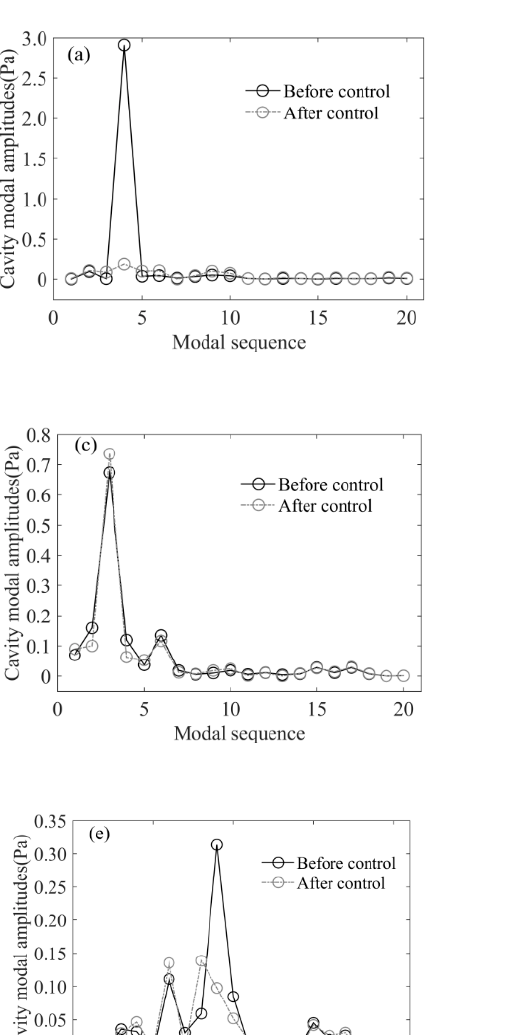
in Figure 7 (Case 3) and Table 6 (Case 3). Note that the (0,1,0), (1,1,0), (2,1,0) and (3,1,0) cavity modes can also transmit energy to the (2,2), (3,2) and (1,2) base plate modes with a substantial quantity. However, the energy contributions from the (0,1,0), (1,1,0) modes are just out of phase with those of the (2,1,0) and (3,1,0) modes. The total contribution of these four cavity modes dissipates each other. Accordingly, less additional control e ff ect is needed to suppress the energy transmission from these cavity modes. The mechanism in the single ribbed case only involves Case 1. The mechanism discussed in case 2 and 3 is a new phenomenon that is not observable in the single ribbed case. The complicated coupling relations and energy transmission rule between the cavity modes and base plate modes in the orthogonally ribbed case generates this novel phenomenon. Although the analysis is carried out only at several specific frequencies, the rule of control is of universality at other frequencies as well.